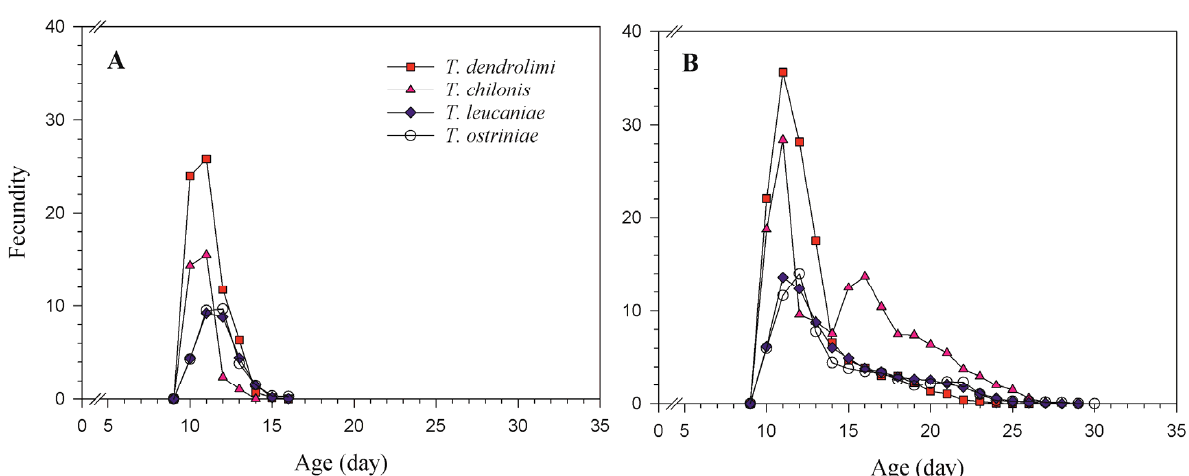
Figure 3. Age-specific net reproductive rate of the population of four Trichogramma species parasitizing C. cephalonica eggs. Fed with water ( A ) and fed with honey ( B ).